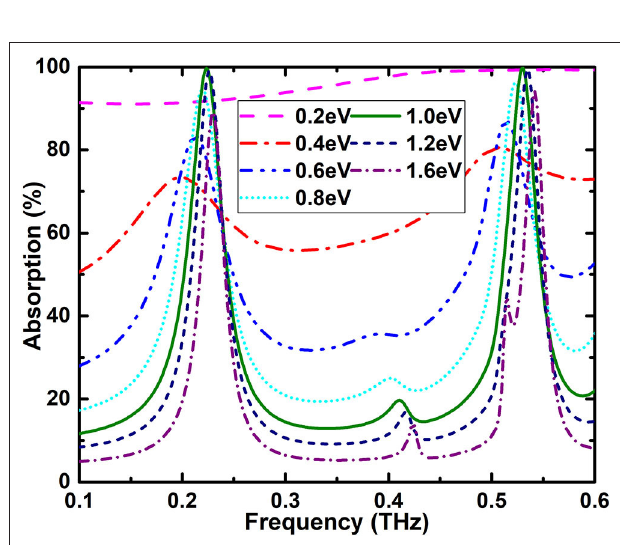
FIGURE 8 | Absorption spectra for the designed perfect absorber with different frequencies and incident angles for TM